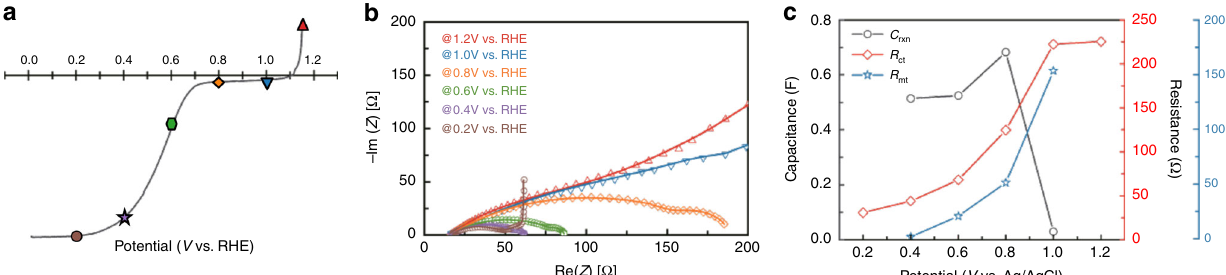
Fig. 1 In situ electrochemical spectrum by home-built spectroelectrochemical cell. a The LSV curve of the py-B12 b Nyquist plots of ORR on py-B12 with concurrent XAS measurement. c The EIS fi tting spectra of ORR recorded with concurrent XAS measurement. All the signals were collected on a home-built spectroelectrochemical cell with a catalyst loading of 100 mg cm − 2 and under O 2 -saturated 0.1-M HClO 4